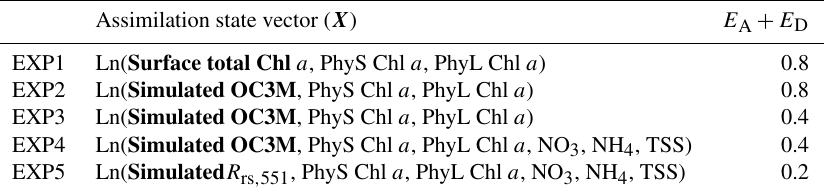
Table 1. The subset of state variables included in the state vector and corresponding sum of the analytical ( E A ) and difference in kind errors ( E D ) expressed as standard deviations in log-space used for the five assimilation system configurations; note that E tot = E A + E D + E R , as per Sect. 2.5.2, and E tot are used on the diagonal elements of the observation error covariance matrix ( R ). The bold variables in the state vector are used in the input to the observation operator. It should be noted than the state variables are transformed by taking the natural logarithm of the variables. The observation error is then applied to the log-transformed state